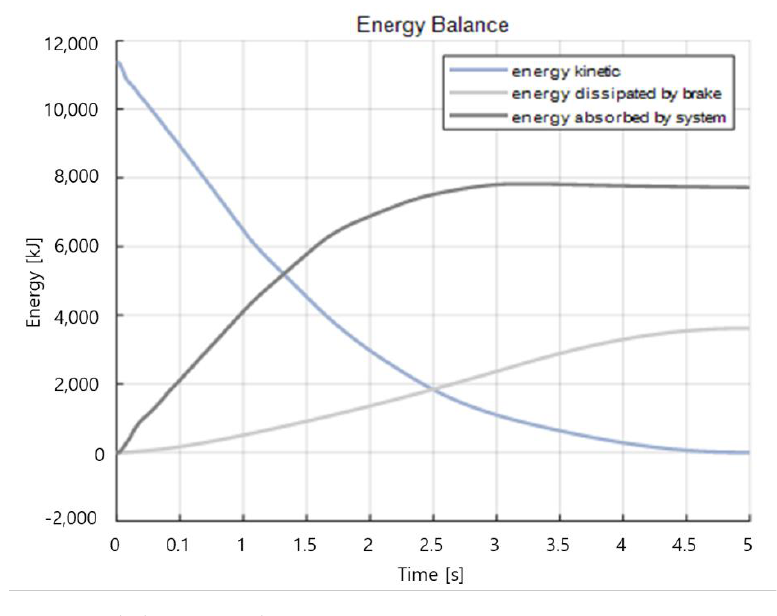
Figure 24. Simulation results (train speed: 25 km/h). Table 3. Result of energy balance.